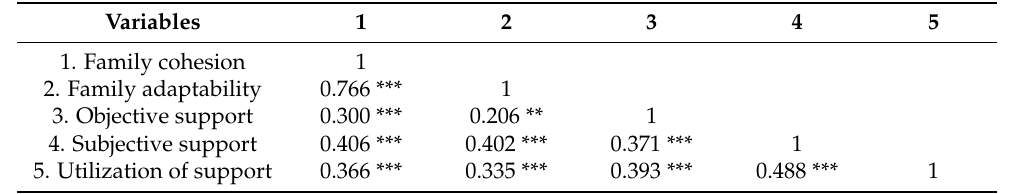
Table 2. Correlations analysis of social support and family functioning.